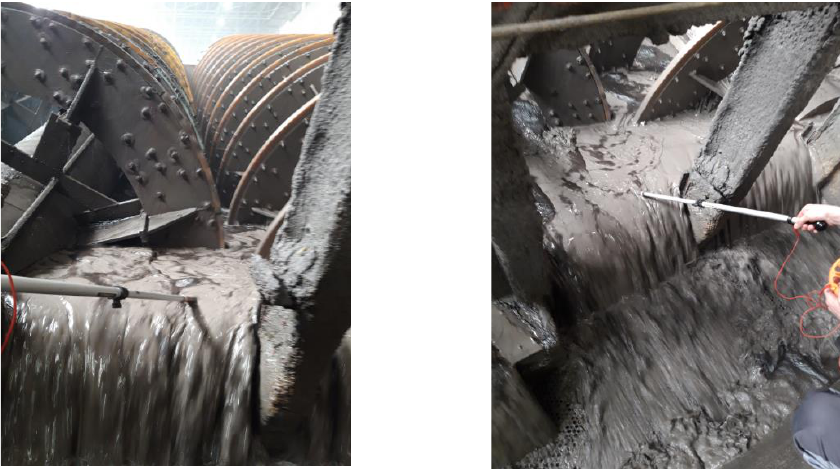
Figure 12. Verification measurements of the classifier spiral potential using a portable electrode.